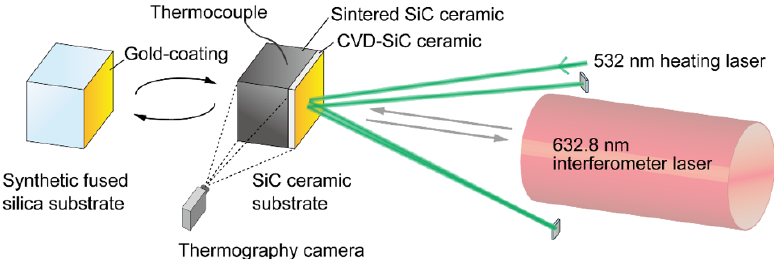
Figure 1. Experimental setup for measuring the temperature and the surface accuracy of the gold-coated mirrors heated with laser irradiation. Details of the gold-coated mirrors based on synthetic fused silica and SiC ceramic substrates are shown. The gold mirror surface is irradiated with the heating laser to heat the substrate several times by folding back with mirrors. The interferometer laser is fired after the heating laser is turned off to avoid the effect of scattering from the heating laser.